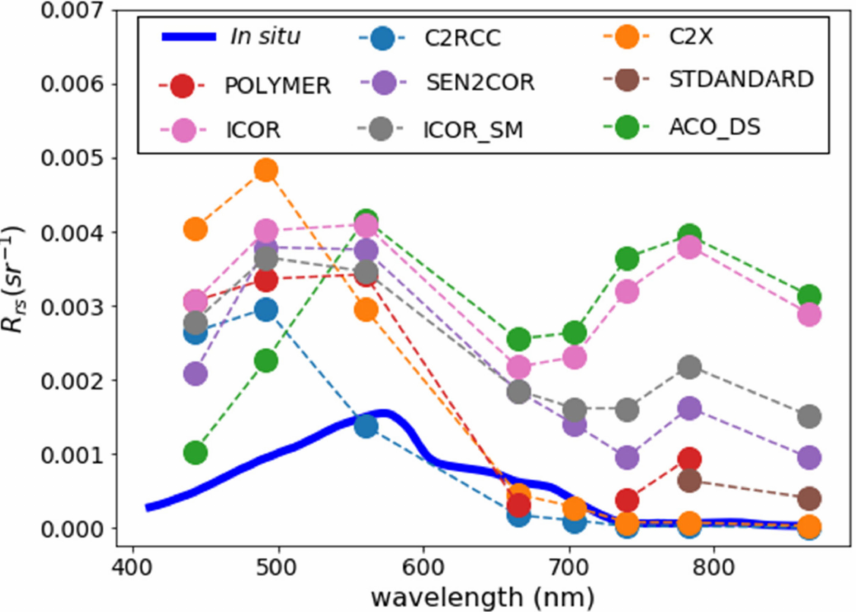
Figure 6. Comparison between the in situ R rs measured by TriOS RAMSES (24 August 2019 18:38 UTC) and the R rs retrieved by each algorithm for the sampling station of 11-631 from the Sentinel-2/MSI observation (29 August 2019 19:09 UTC). The measured Chla concentration was 1.55 µ